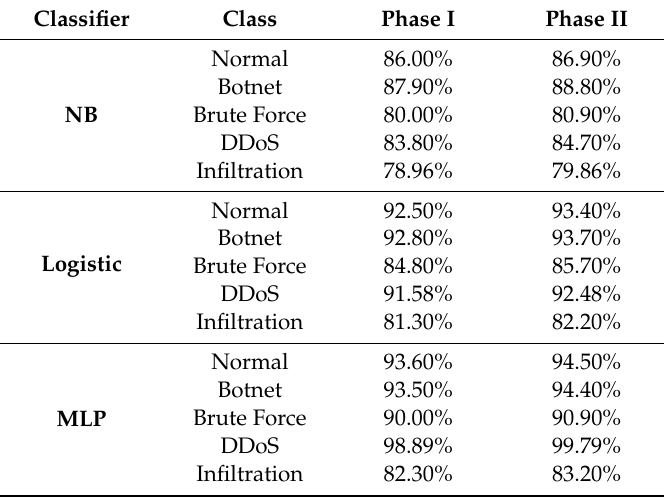
Table 6. Classifiers’ accuracy detection for di ff erent classes of